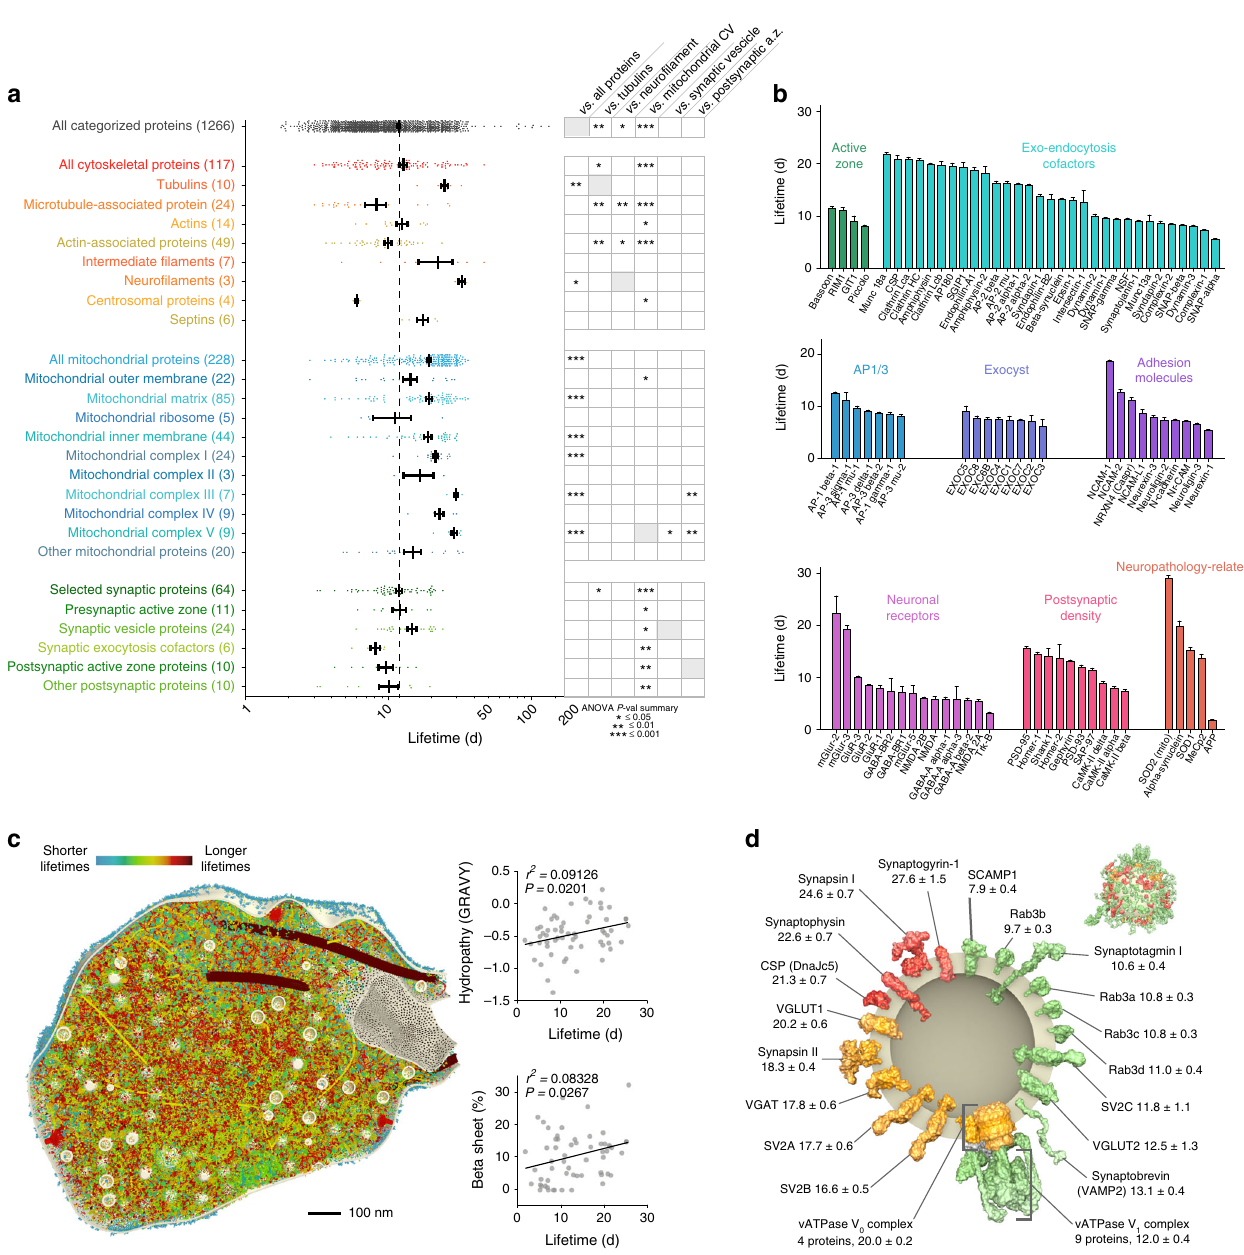
Fig. 3 Detailed lifetimes of cytoskeletal, mitochondrial and synaptic proteins. a A subdivision of lifetimes for cytoskeletal, mitochondrial, and synaptic proteins subgroups 19 – 24 . The analysis of variance (ANOVA) on the right summarizes P -values for the indicated comparisons, following Bonferroni post hoc test (* ≤ 0.05, ** ≤ 0.01, *** ≤ 0.001). b The lifetimes of 90 proteins of particular interest, subdivided in 8 groups, are detailed. For each protein, the 95% con fi dence interval is reported as a measure of the error. c A section through a 3D model of the synaptic bouton, indicating 60 proteins shown in the copy numbers (as in ref. 23 ) and pseudo-colored as determined by their lifetime values. The two insets on the right side represent scatter plots of the lifetimes vs. either the hydropathy (upper panel) or the percentage of beta sheet stretches in the secondary protein structure (lower panel). In both cases there is a positive correlation between lifetimes and these values, indicating that hydrophobic and more structured proteins tend to live longer in the presynaptic bouton (ANOVA P -values ≤ 0.05). d A 3D view of a modeled synaptic vesicle, showing the lifetimes of 20 proteins (or protein complexes), as determined from the synaptic vesicle fraction of the brain cortex, see also Fig. 6. The proteins are color-coded from short-lived (green) to long-lived (red). The numbers indicate the lifetimes, in days and the error corresponds to the 95% con fi dence interval. The inset in the upper right corner is a synaptic vesicle, with proteins color coded for their lifetimes and shown in the appropriate copy numbers 23 . For the synaptic vesicle the data from the cortex subcellular fractionation has been used (see also Fig. 6), while all other data is from brain cortex